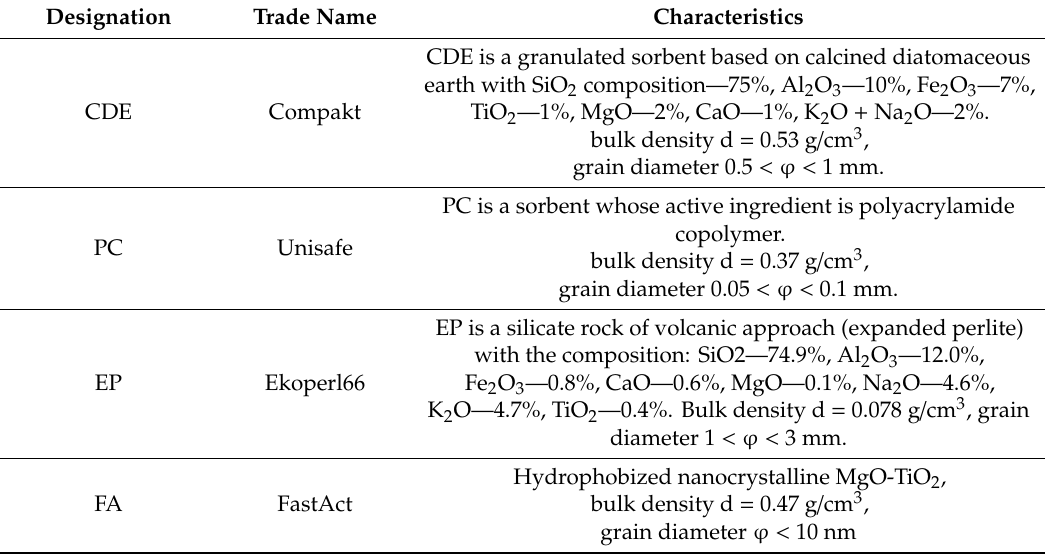
Table 1. The characteristics of the tested